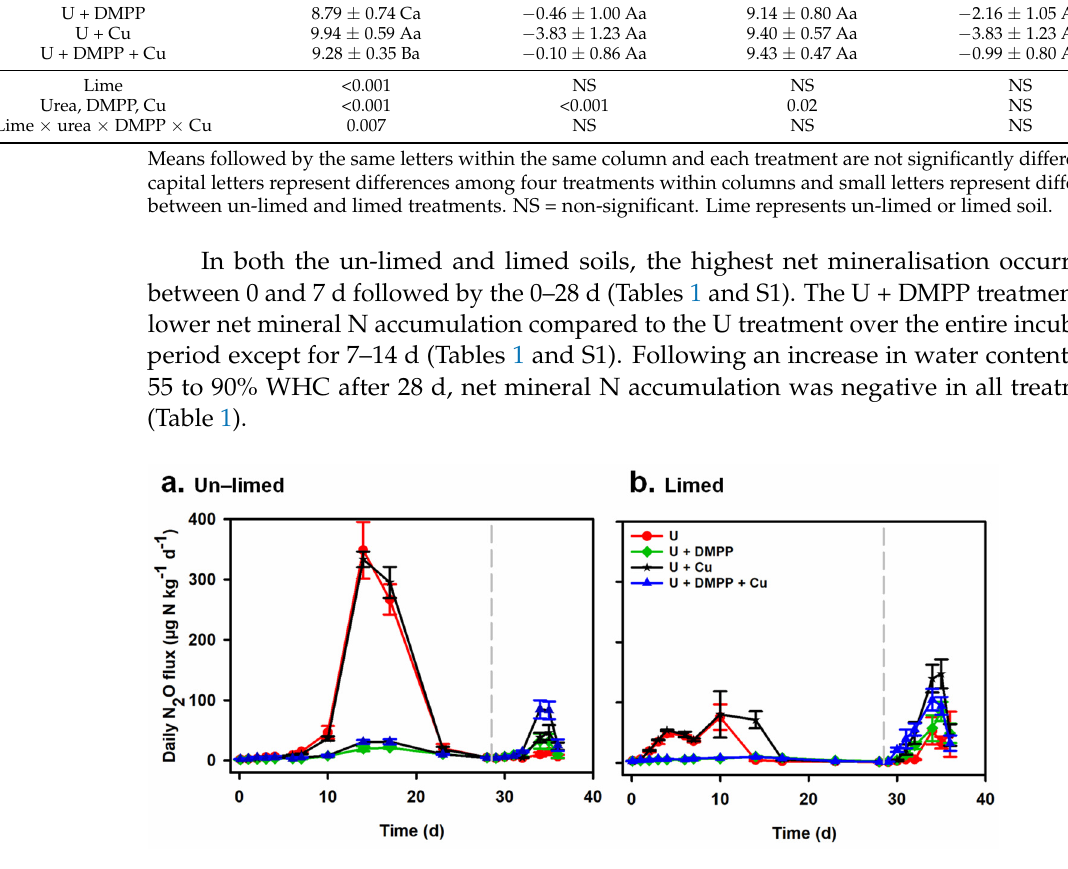
Figure 5. Effects of urea, DMPP, and Cu on N 2 O emissions from an acidic sugarcane cropped soil in ( a ) un-limed treatment and ( b ) limed treatment. The soil water was maintained at 55% WHC for the first 28 d then increased to 90% WHC for the remainder of the experimental period (as indicated by the grey broken vertical line). Data are the means of four replicates ±SE. Table 2. Cumulative N 2 O emissions from the un-limed and limed sugarcane cropped soil. The soil water was maintained at 55% WHC for the first 28 d then increased to 90% WHC for the remainder of the experimental period. Data are the means of four replicates ±SE.